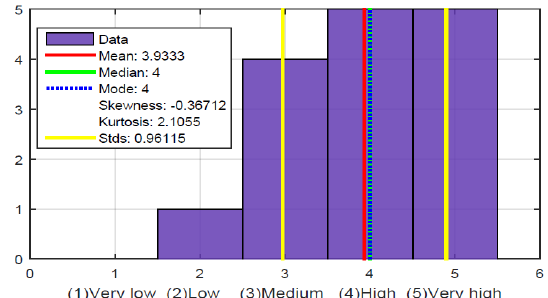
Figure 23. To what extent were you able to locate the soccer ball through the vibrations generated by the glove